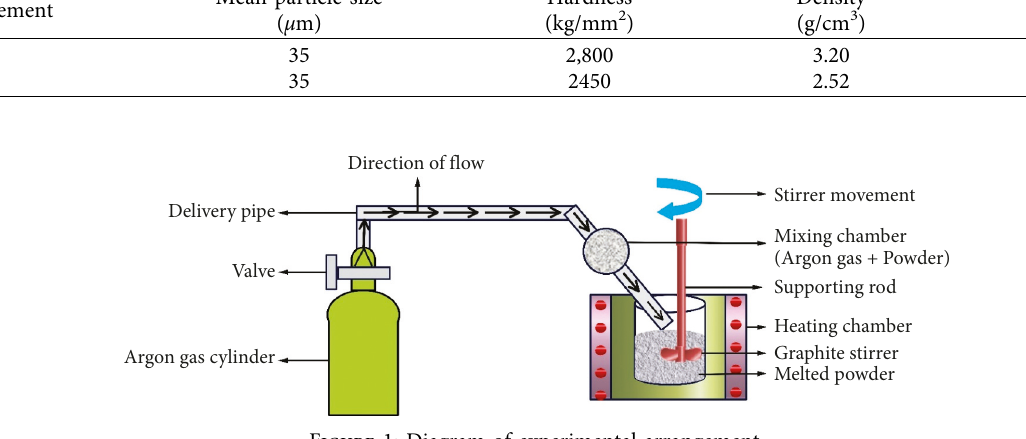
Figure 1: Diagram of experimental arrangement.